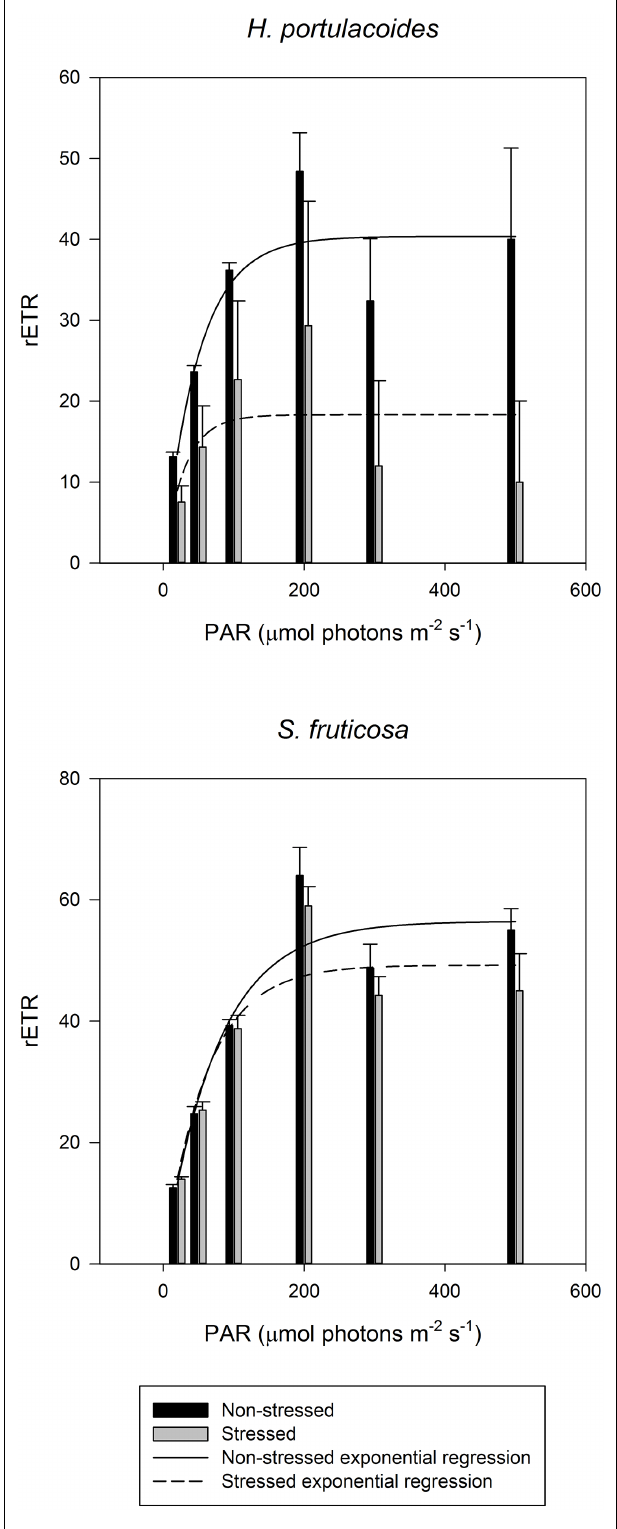
FIGURE 5 | Electron transport rate (rETR) at different light intensities in field stressed (gray) and non-stress individuals (black) of Halimione portulacoides and S. fruticosa (average ± SE, N =